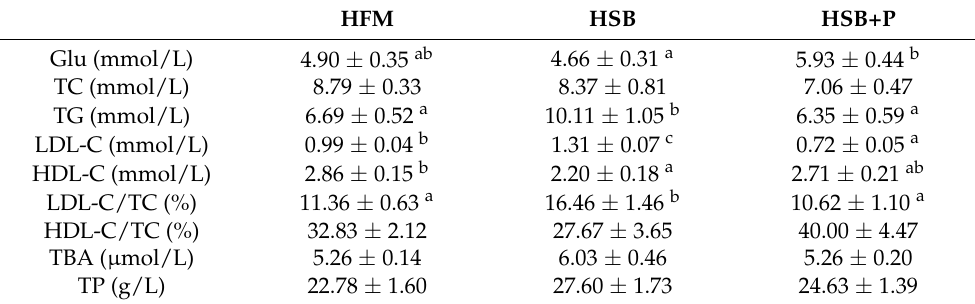
Table 5. Effects of experimental diets on plasma biochemical parameters of largemouth bass (Mean ± SEM, n = 8).